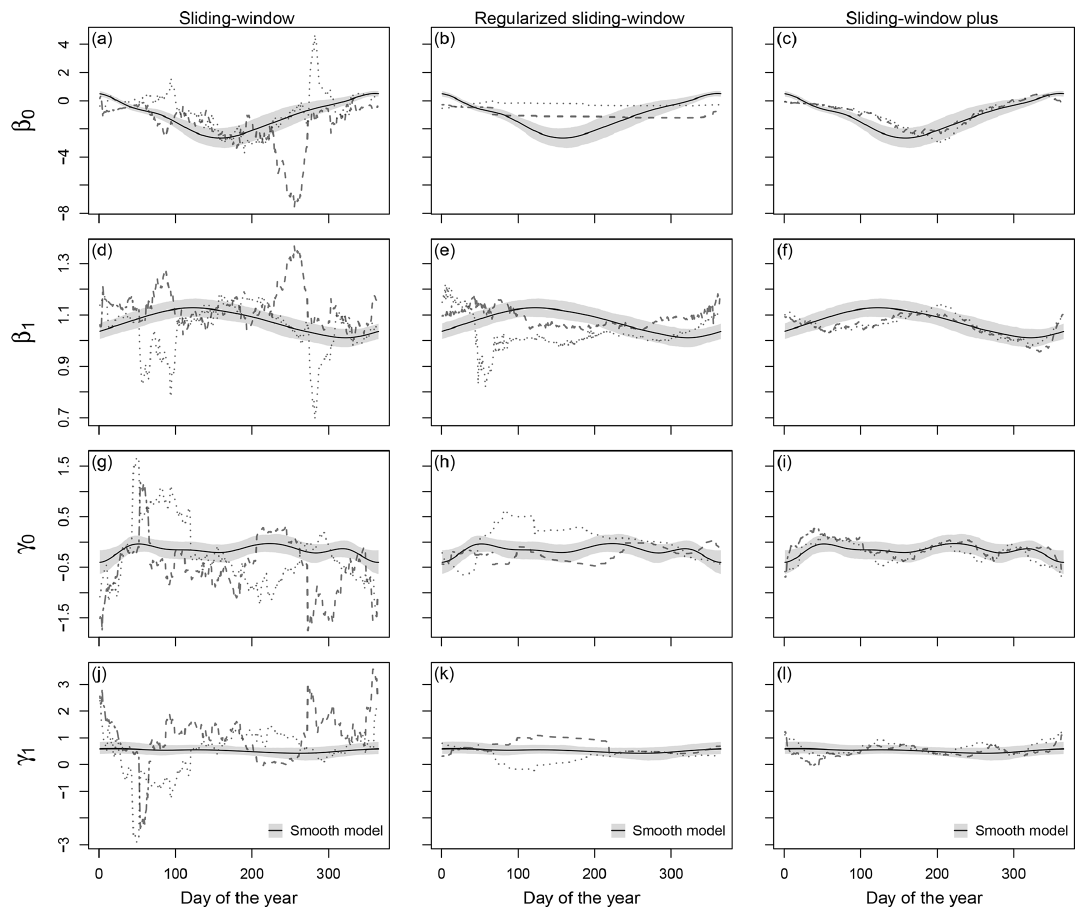
Figure 4. As Fig. 3 but for Hamburg at forecast step + 36h (valid at